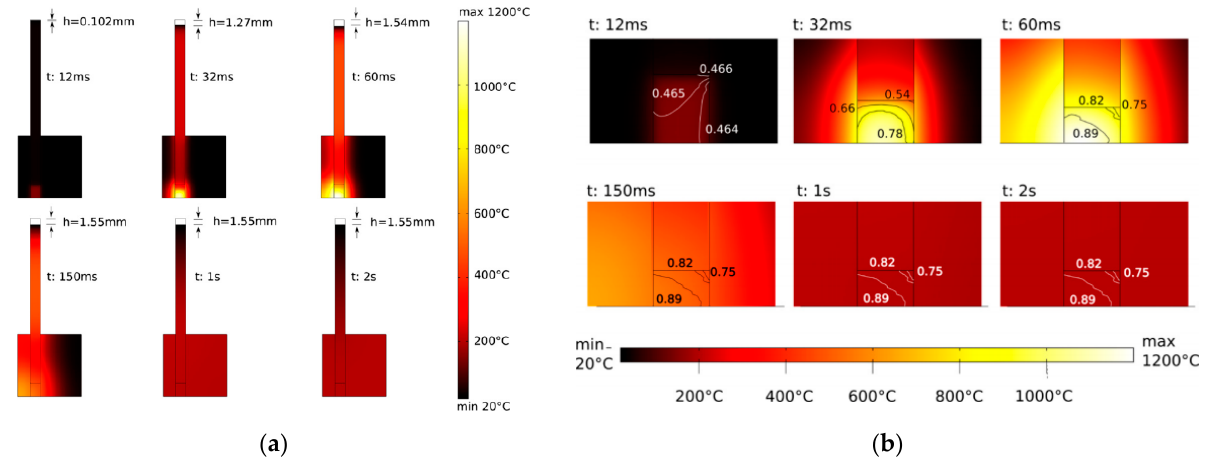
Figure 3. Finite elements method (FEM) simulation of the EDC process of a hollow cylindrical piece. Values of temperature, shrinkage and densification for different times during processing of Cu-diamond powders: ( a ) general overview; ( b ) detail of the zone near the powders. Reprinted with permission from ref. [52], Copyright 2015 John Wiley and Sons.